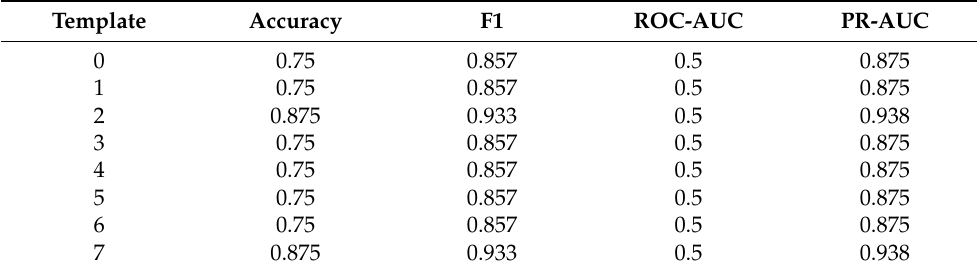
Table 6. Classification in eight test data of ensemble voltages on 1Y re AF through LOOCV.